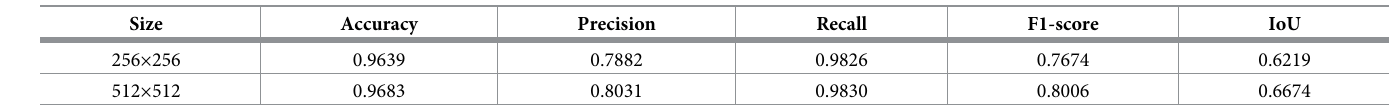
Table 3. Evaluation of accuracy metrics of CSP_UNet with different input sizes.